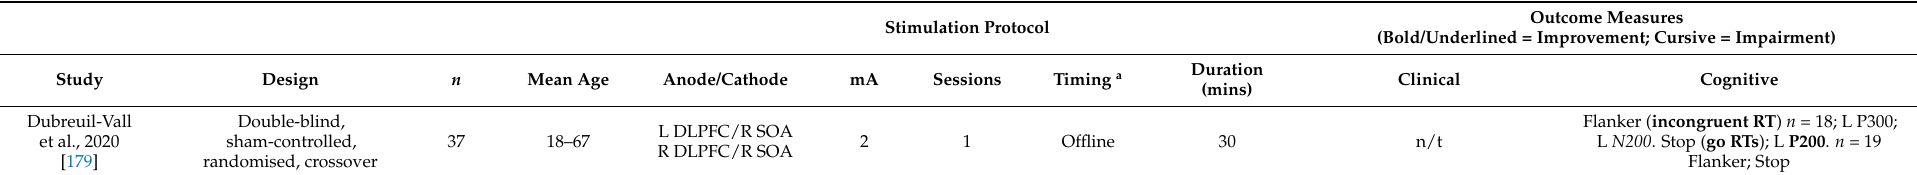
Table 2. Cont. Stimulation